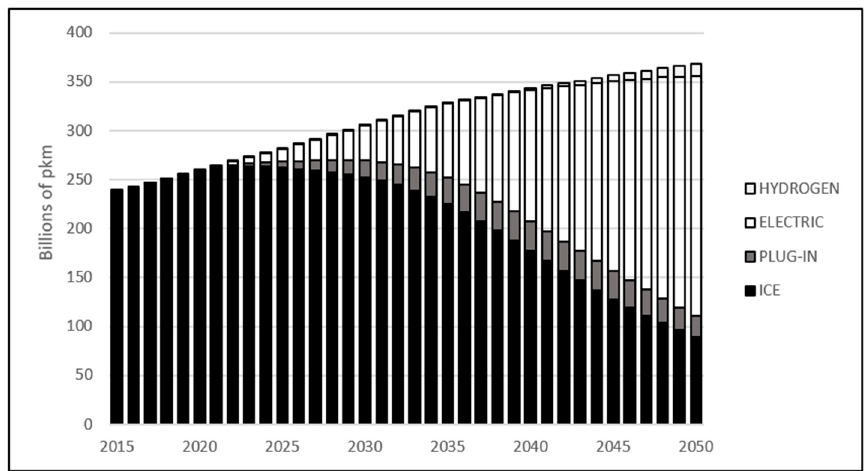
Figure 5. Passenger road transport activity in Poland in the years 2020–2050 [in pkm]. Source: own calculations based on TR 3 E model results.